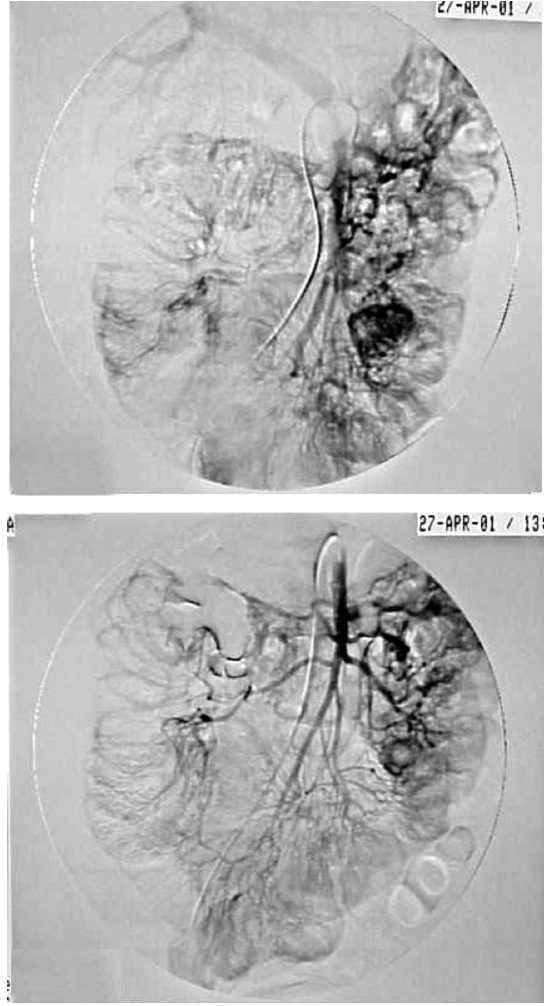
Figure 2 - Digital arteriography showing hypervascularization and multiple microaneurysms in the branches of the superior mesenteric artery, which is compatible with